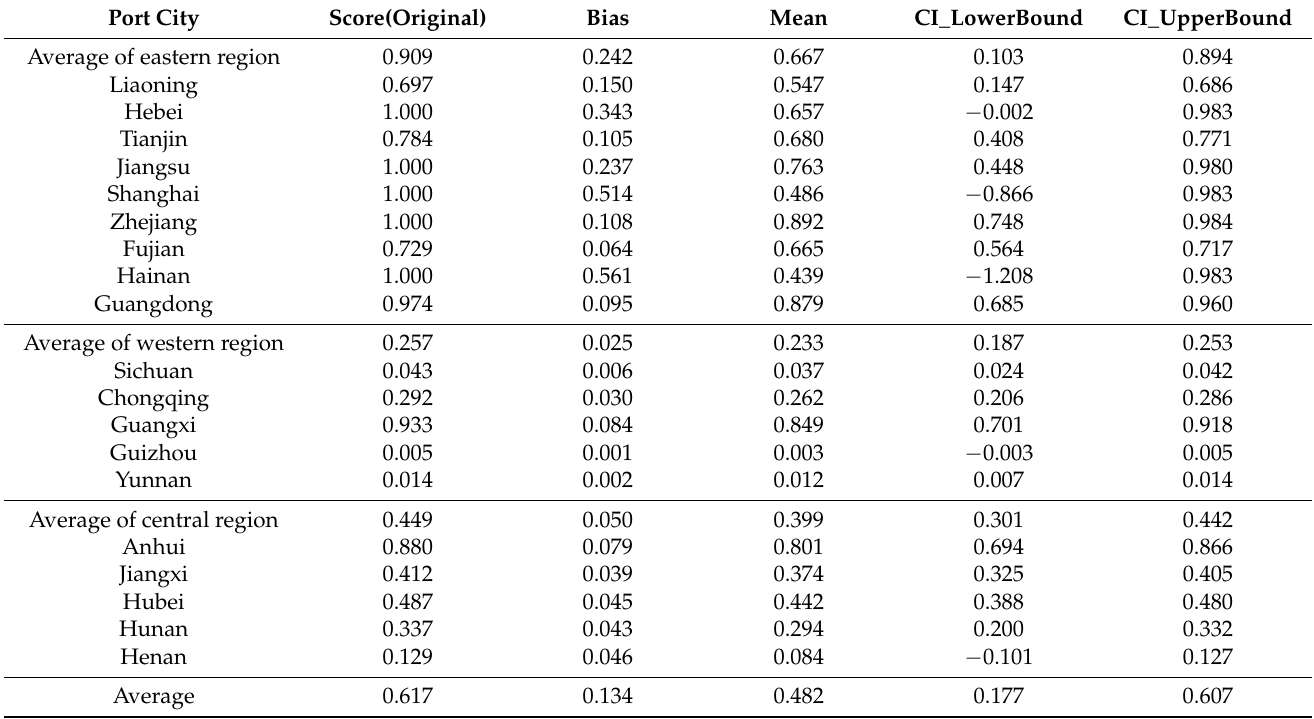
Table 5. The results of